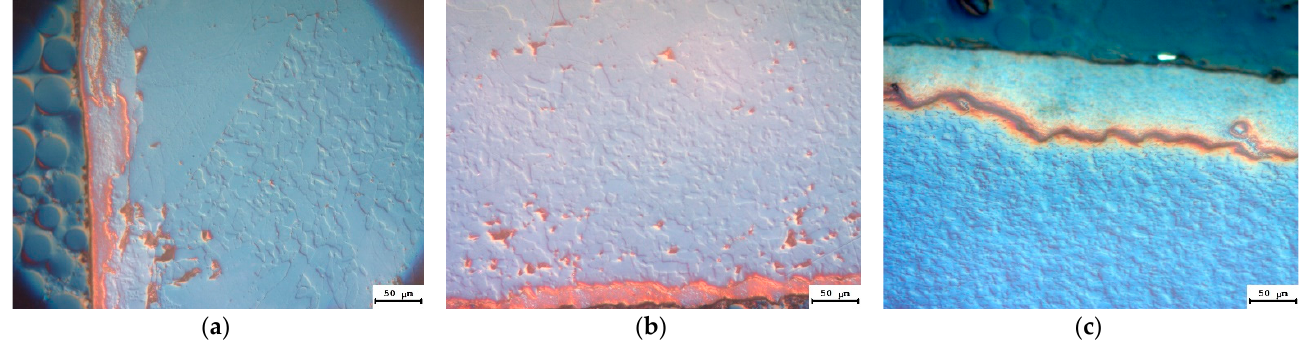
Figure 7. Side surfaces of the YPO 4 :Gd ceramic samples irradiated with different fluences. F, cm − 2 : ( a ) 1 × 10 12 , ( b ) 3 × 10 12 , ( c ) 3 × 10 13 .